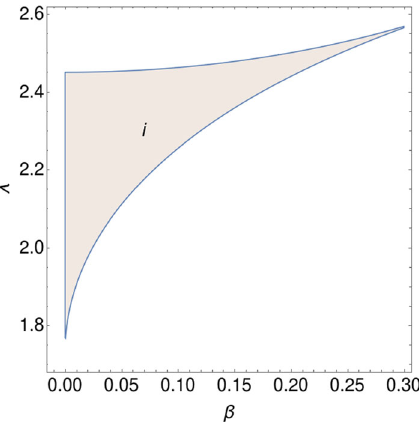
Fig. 1 Region of existence for the critical point E + . They are deceler- ated saddle points in all region i